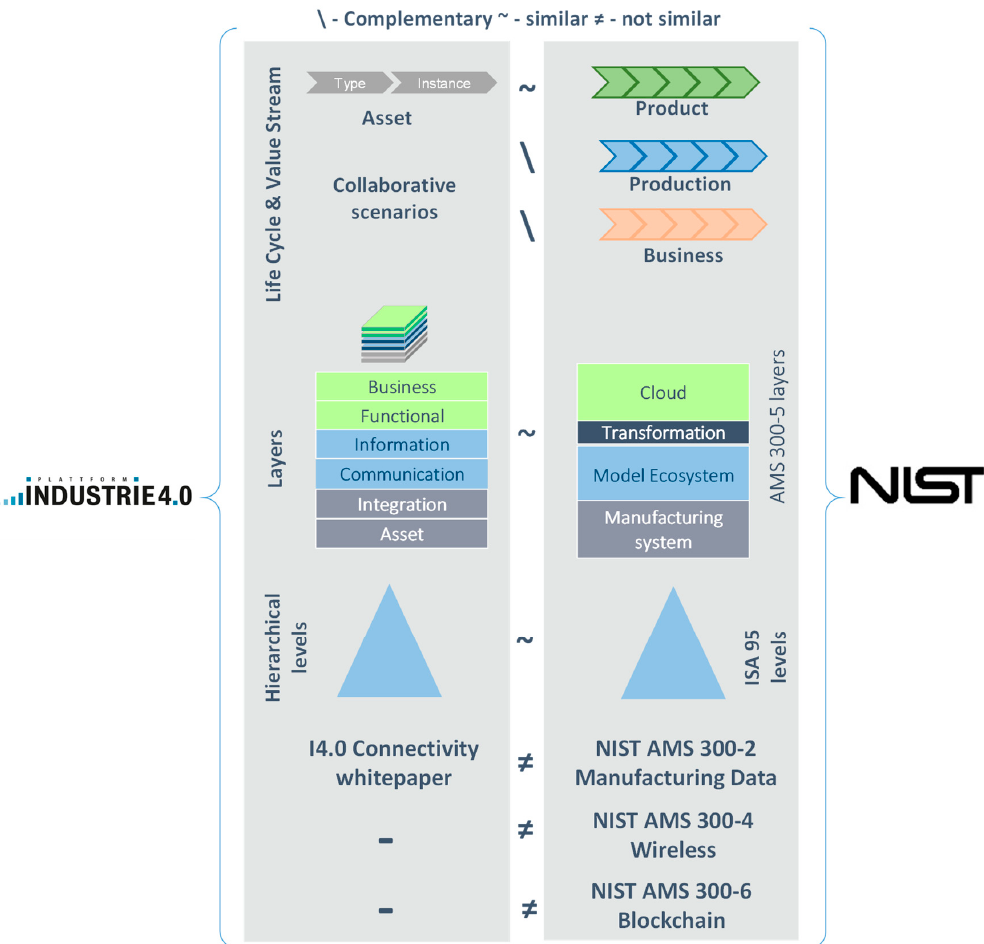
Figure 4. Alignment of RAMI 4.0 and Smart Manufacturing Ecosystem.